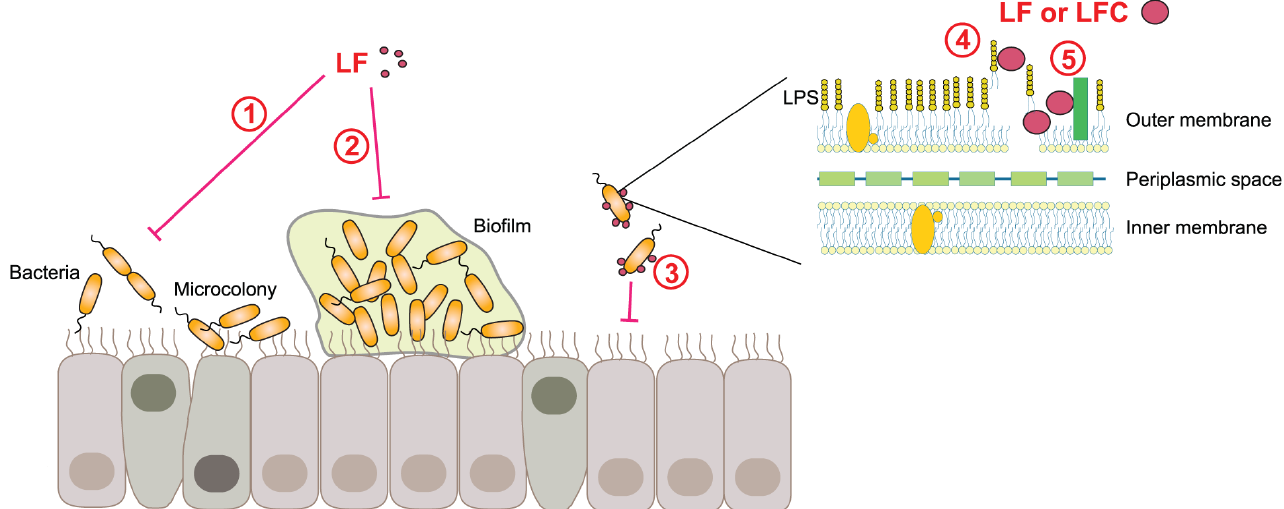
Figure 4. Antimicrobial actions of LF and LFC. LF has antibacterial activity toward a spectrum of different bacterial pathogens, through iron sequestration, which is bacteriostatic (1), or leads to bacterial twitching that prevents biofilm formation (2). Moreover, via its N-glycans, LF acts as a soluble decoy receptor for invasive pathogens to disrupt their adherence to host cells and cell invasion strategies (3). LF and LFC can cause membrane permeabilization (4) and bind and neutralize bacterial virulence mechanisms, e.g., the type III secretion system of EPEC (5).